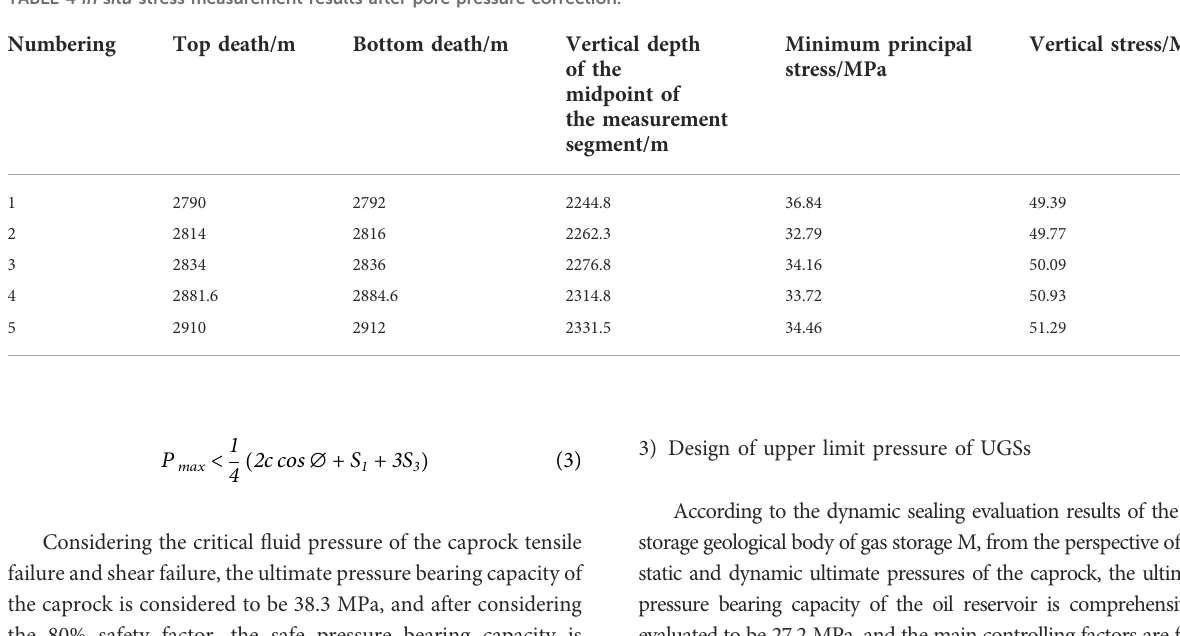
TABLE 4 In situ stress measurement results after pore pressure correction.